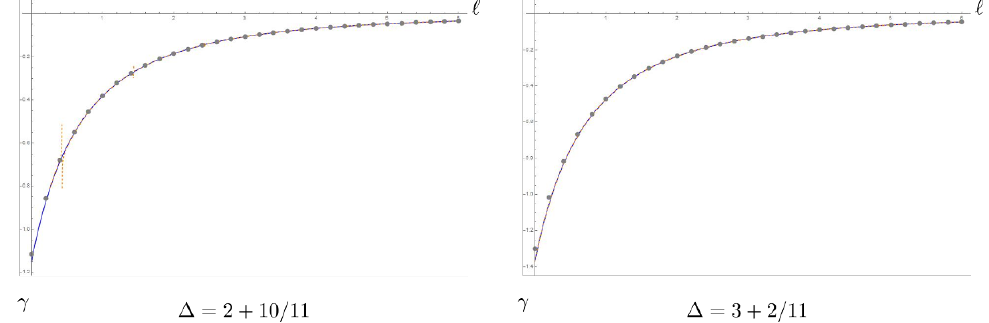
Figure 3 . The plot of the expression (2.36) obtained by evaluating the spectral integral is in tick blue, the expression (3.4) in dashed orange and the (cid:12)rst three terms of the large spin expansion in 1 = J in gray dots. We considered d = 4 and (cid:28) 0 = 5 = 2, with (cid:1) = 2 + 10 = 11 (l.h.s.) and (cid:1) = 3 + 2 = 11 (r.h.s.). In this case the expression (3.4) precisely coincides with analytic in spin result (2.36) obtained by evaluating the spectral integral and with the (cid:12)rst three terms of the asymptotic 1 = J expansion. A small deviation can be observed for ‘ <